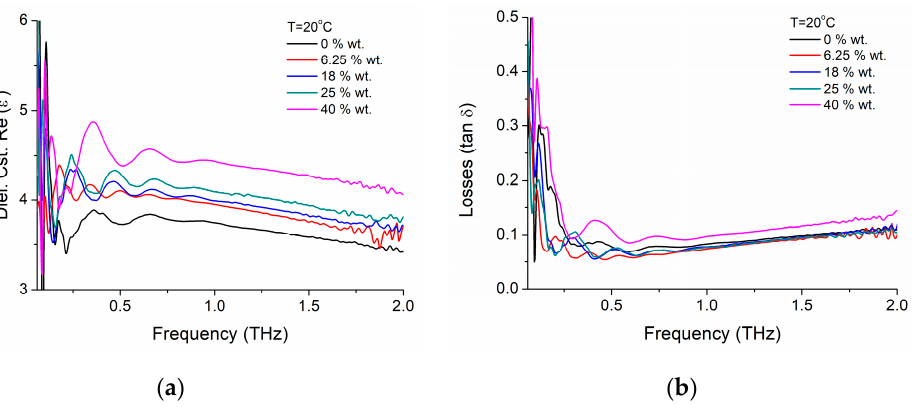
Figure 4. Room temperature frequency-dependent response of ( a ) dielectric constant e ′ and ( b ) losses of xBTO-(1-x) gelatin composites thick films with 0 wt%, 6.25 wt%, 18 wt%, 25 wt%, and 40 of xBTO-(1-x) gelatin composites thick films with 0 wt.%, 6.25 wt.%, 18 wt.%, 25 wt.%, and 40 wt%.